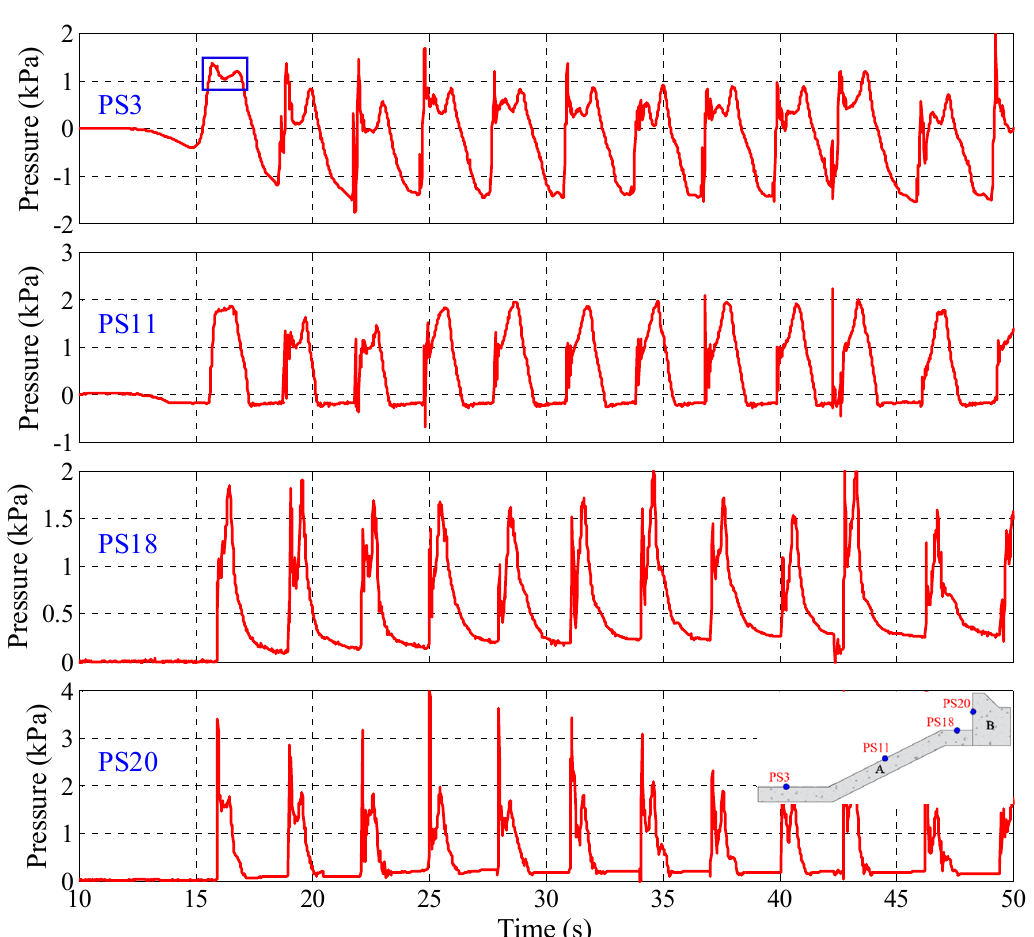
Figure 9. Time history of the wave impact recorded in Test 3 at the four typical positions (hydrostatic pressure is excluded).